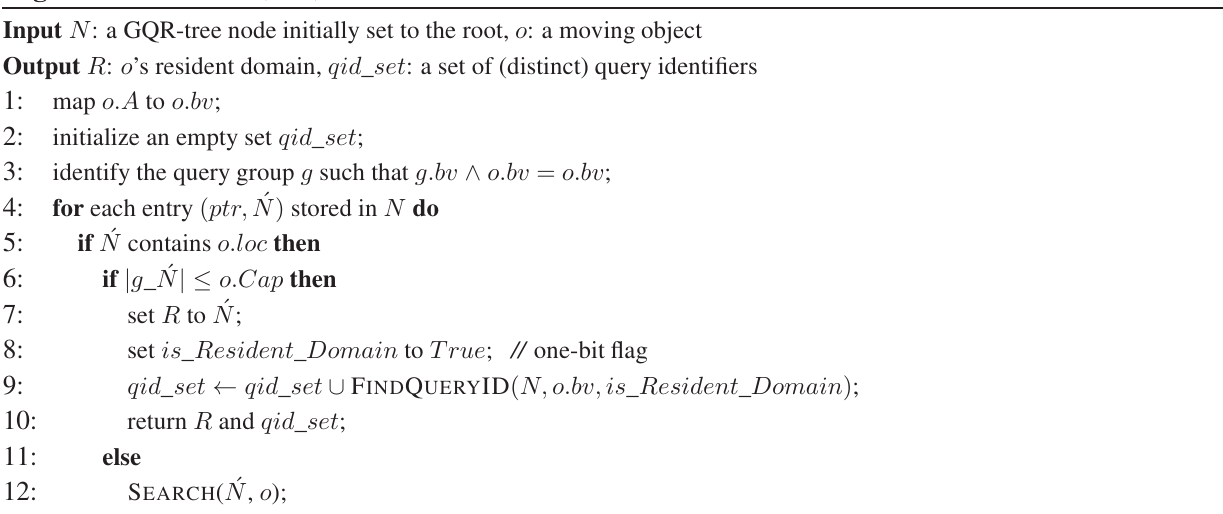
Algorithm 1 S EARCH ( N , o